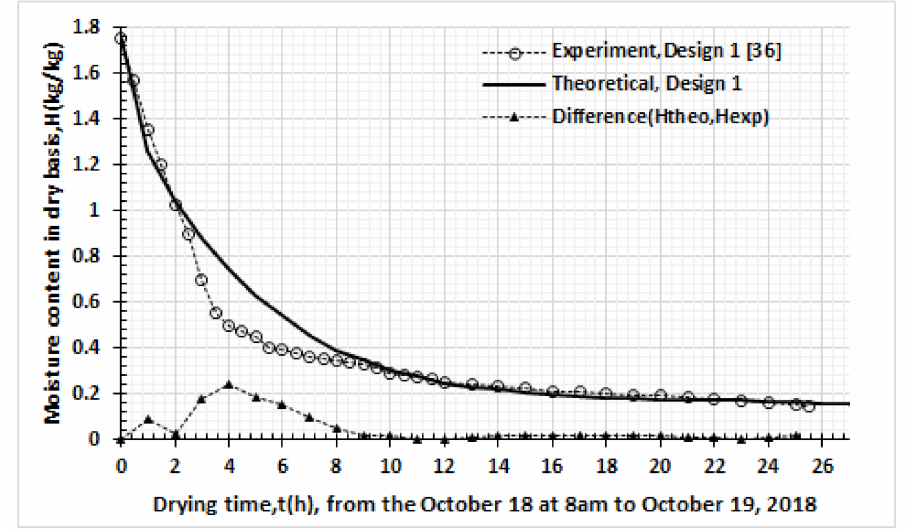
Figure 5. Validation of the model using experimental data given by Tieu et al. [36] in Yamoussoukro, October 2018, design 1.